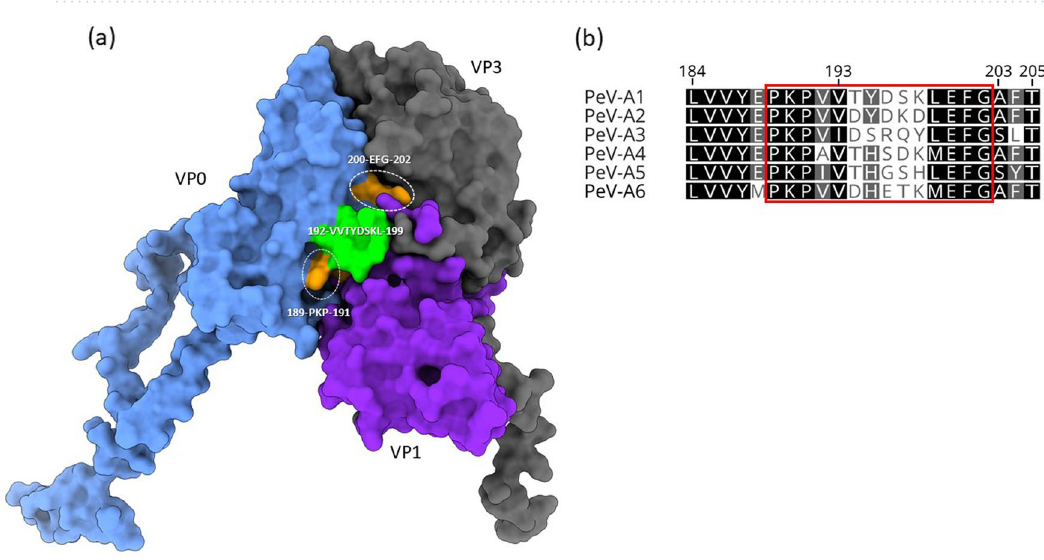
Figure 5. Consensus sequence alignment and location of the epitope on a parechovirus capsid. ( a ) Top-down surface view of PeV-1 structure (PDB: 4z92) asymmetric unit consisting of VP0 (blue), VP1 (magenta), and VP3 (grey) proteins. The core of the putative epitope is colored in green, while the residues of the conserved flanking regions that exhibit surface exposure are colored in orange. Structurally the epitope is located near the junction of the three capsid proteins, which is also structurally close to the RGD motif in VP1, known to be important for integrin binding. The highly conserved flanking regions of the epitope are likely important in stabilizing the base structure of the epitope, which itself has a higher degree of flexibility. ( b ) Sequence alignment of the VP0 residue range obtained from Pepscan’s CLIPS analysis for PeV-1–6 with residues numbered based on the PeV-A1 (Harris) prototype sequence (acc. no. L02971). The area boxed in red represents residues with surface exposure. The flanking regions of the core, VVTYDSKL, are seen highly conserved across different PeV type, while the core alignment itself shows higher